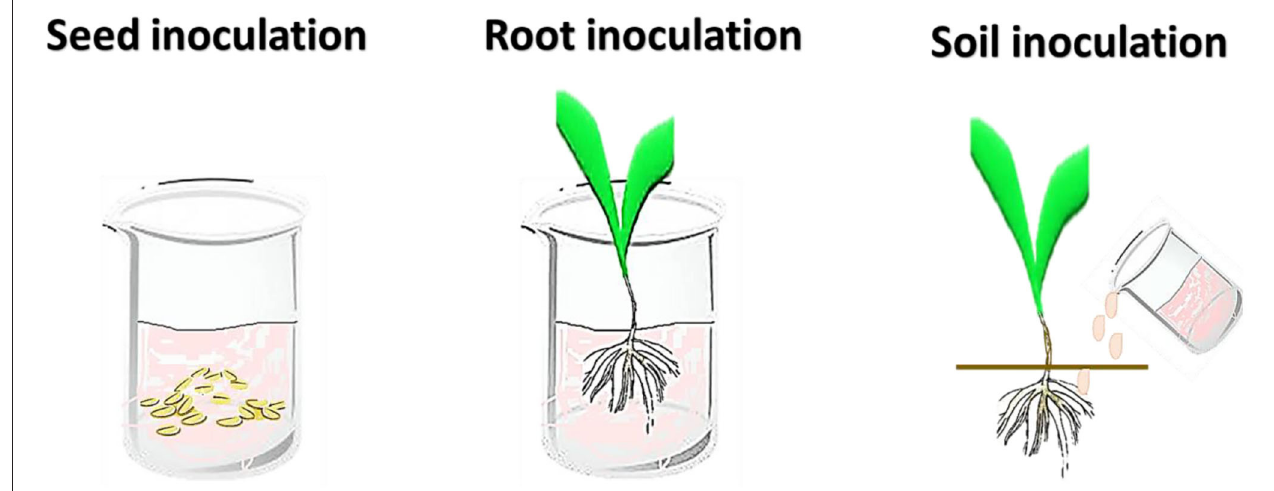
FIGURE 2 | Inoculation methods on plant growth-promoting microbes in host